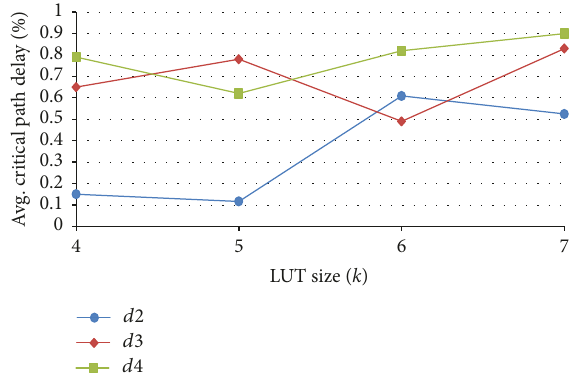
Figure 12: Average critical path for 𝑁 = 10 , 𝑘 = 4–7, and 𝑑 = 2–4 over the 20 MCNC benchmark circuits.